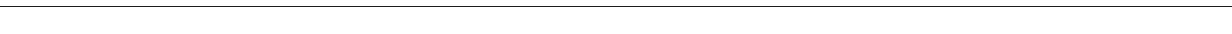
Fig. 1 Optogenetically evoked dendritic Ca 2+ spikes in the local fi eld potential. a Schematic diagram of the experiment. b A photomicrograph of the micro- periscope system with collimated light in the air ( top ) and in the cortical tissue ( bottom ). c A cortical slice showing the virally transfected region co- expressing Channelrhodopsin 2 (H134R) and eYFP. Scale bar represents 500 μ m. d Optogenetically evoked potentials at 16 cortical depths with the highest light intensity (12 mW/mm 2 ), averaged over 100 traces in one animal. Shaded area indicates the late sink. Blue bar indicates the timing of L5 light stimulation. e Principal component analysis of 100 waveforms ( top left ) recorded at 600 μ m below the pia (indicated by the arrow head in d ) revealed three types of waveforms: those without discernable late spikes ( bottom left ); those with broad spikes ( top right ); those with huge-amplitude, sharp spikes ( bottom right ). f Current source density (CSD) analysis of the evoked potentials averaged over 100 measurements ( left ) and the expanded view between 300 and 900 μ m below the pia showing that the late sink initiated at 600 μ m below the pia and propagated both upward and downward. g The late sink depends on light intensity (one-way ANOVA, p < 0.001, n = 17 animals). Post hoc multiple comparison test indicates that the amplitude upon highest light intensity signi fi cantly differed from others (all p < 0.001). h Schematic diagram of Ca 2+ fl uorescence imaging experiments ( left ). The sharp increase in Ca 2+ fl uorescence measured in L2/3 coincided with the Ca 2+ spikes measured with Michigan probe at 600 μ m below the pia ( right ). Black and gray traces are the average of 10 representative measurements with and without discernable Ca 2+ spikes respectively. The light intensity for L5 stimulation was highest (12 mW/mm 2 ). i The late sink was unaffected by local application of the synaptic blocker CNQX (100 μ M) in L2/3 and L5 (both p > 0.05, Wilcoxon signed rank test, n = 6). j Multi-unit activity (MUA) in L2/3 and L5 after optogenetic stimulation of L5 (averaged over n = 5 animals), at the highest light intensity (12 mW/mm 2 ). Shaded area indicates the period when the late sink was evoked. Blue bar indicates the timing of L5 light stimulation. k The late sink signi fi cantly decreased by local application of 50 μ M Baclofen in L2/3 ( p < 0.05, Wilcoxon signed rank test, n = 5). l The late sink also signi fi cantly decreased by local application of 3 μ M TTX in L5 ( p < 0.05, Wilcoxon signed-rank test, n = 3)